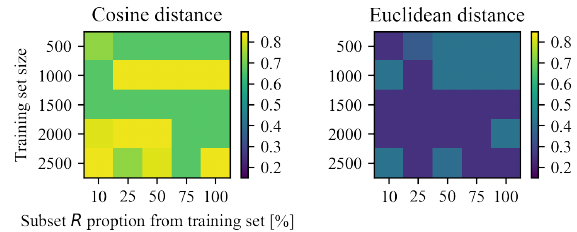
Figure 12. Area under curve value of the MLM using variance with cosine distance (left) and Euclidean distance (right) varying size of the training set and proportion subset R